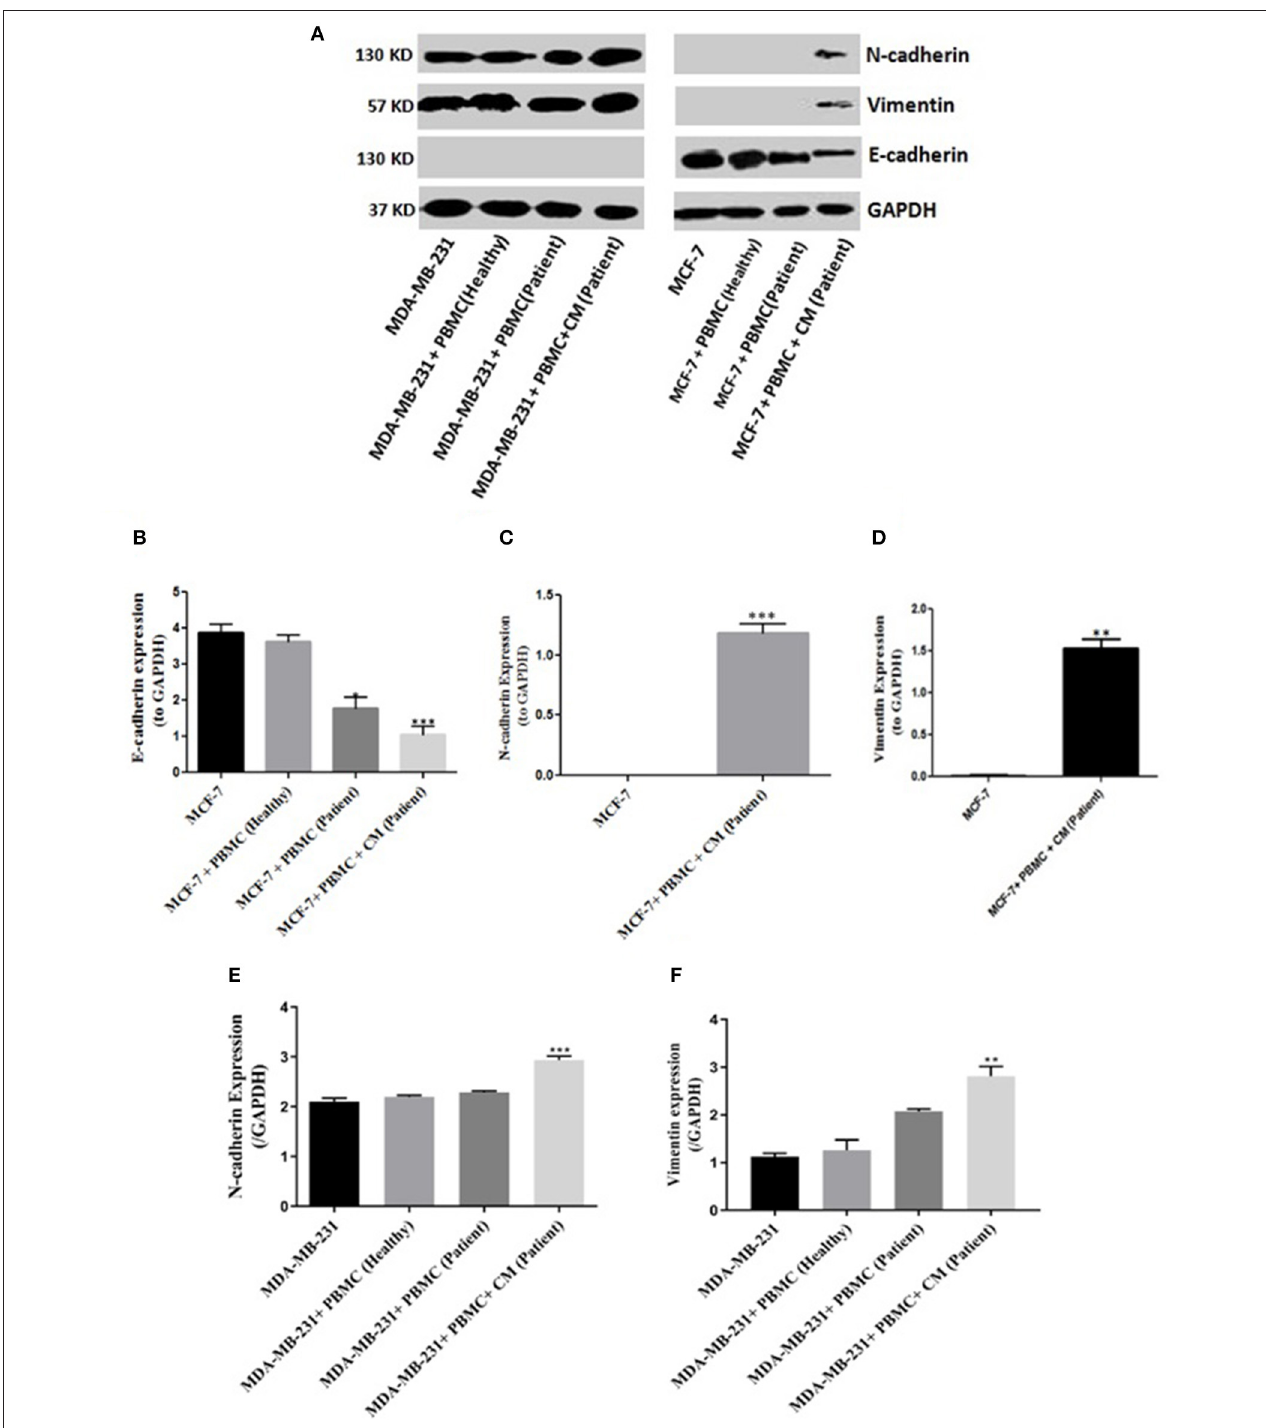
FIGURE 1 | EMT markers expression in breast cancer cells. Immunoblot analysis illustrates expression of various epithelial and mesenchymal markers in breast cancer cells: (A) MCF-7 cells (right column) as well as MDA-MB-231 cells (left column). (B–F) Quantification of the intensity using the ImageJ software. Data are representative of at least three independent experiments with three biological replicates (* p < 0.05, ** p < 0.01, *** p < 0.001).